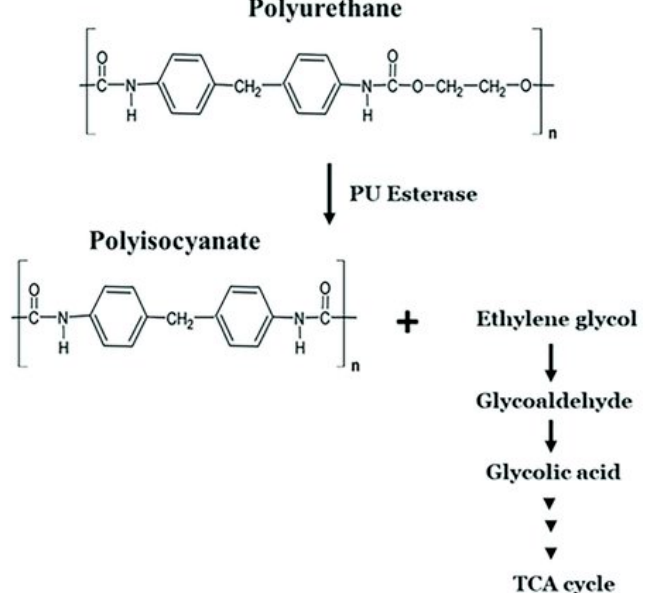
Figure 3. Microbial degradation pathway of polyurethane [56]. TCA cycle: the cycle of tricarboxylic acids. PU esterase: polyurethane esterase.